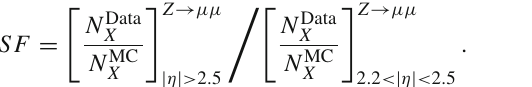
(cid:14) ( X ) (cid:8) (cid:14) ( X | ID ) × (cid:14) ( ID | MS ) = (cid:8) (cid:14) ( X | ST ) × (cid:14) ( ST | ID ∨ CT if p